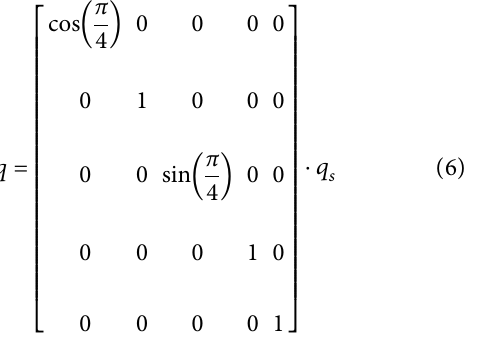
Figure 2: Coordinate system of MSCSG.